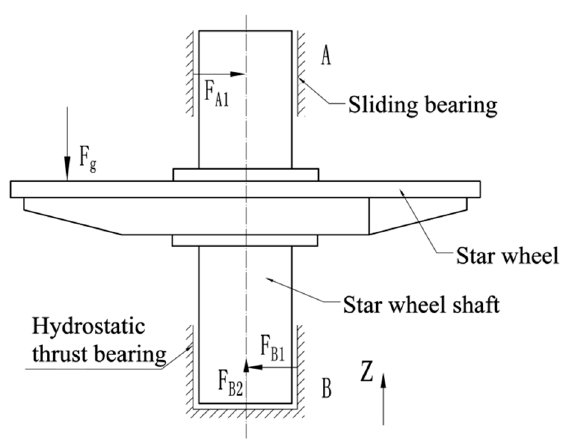
Figure 4. Illustrations of forces acting on a star wheel shaft.